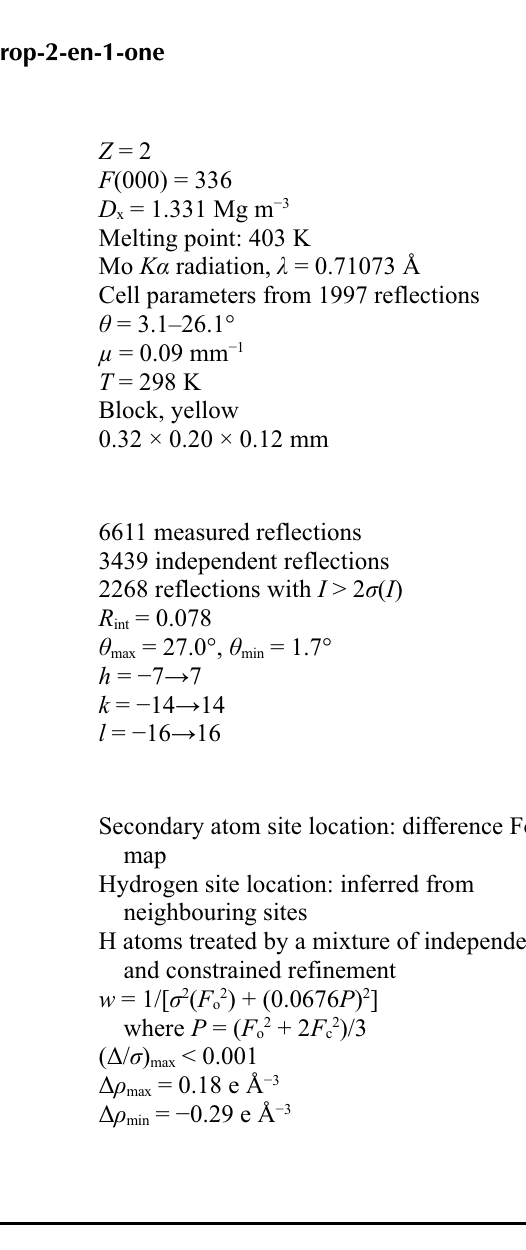
Figure 1 View of (I), showing the atom-labeling scheme. Displacement ellipsoids are drawn at the 50% probability level. The dashed line indicates an intramolecular hydrogen